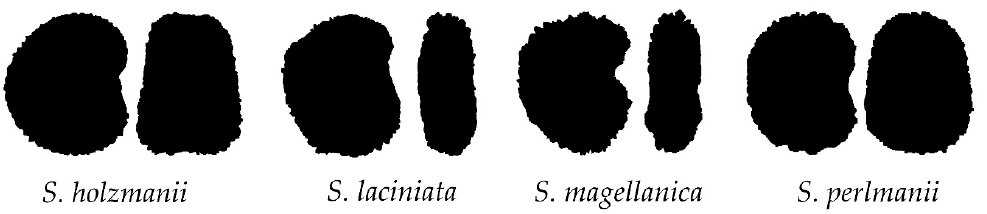
Figure A4. Average silhouettes for the lateral and dorsal views of species in the echinate group.